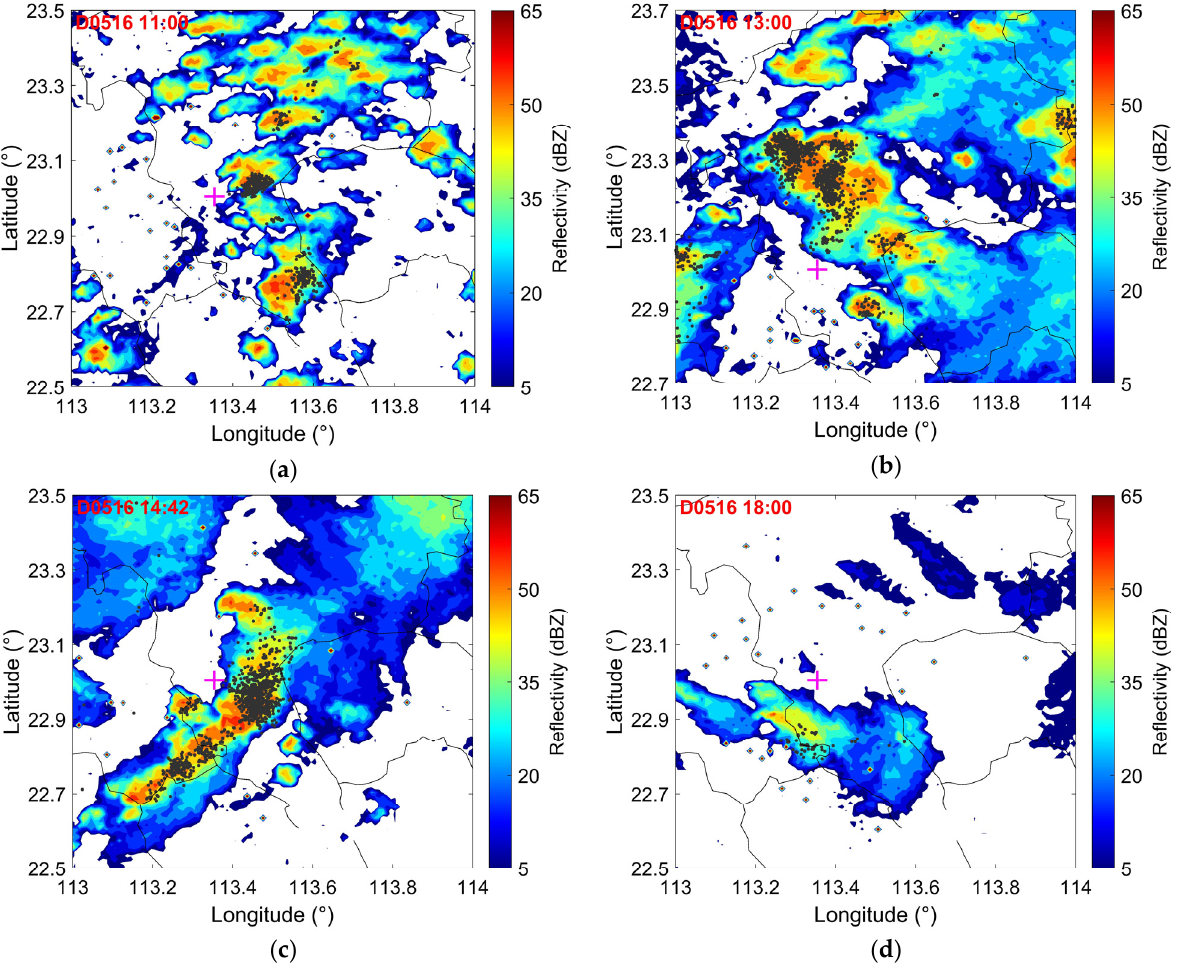
Figure 4. Staking chart of radar echo and lightning location. Radar reflectivity at a different time within the analysis area. The black dots show the spatial distribution of total lightning on 16 May. ( a ) The thunderstorm was in its initiating stage when the reflectivity was >50 dBZ without corresponding lightning events in some place. ( b , c ). The thunderstorm was in its active stage when the reflectivity was >40 dBZ with quantities of lightning events. ( d ) The thunderstorm was in its dissipating stage when the reflectivity was <35 dBZ with dispersed lightning events.